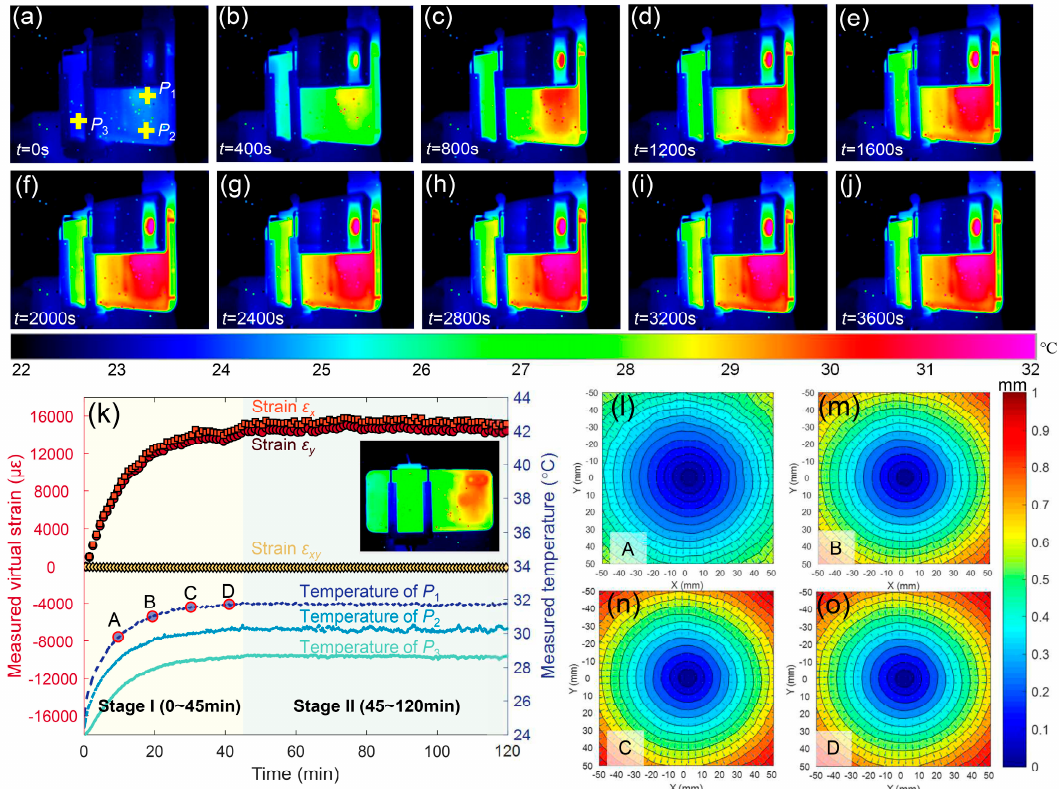
Figure 6. Temperature maps of the smartphone back surface monitored by the thermal camera during the static test: ( a ) t = 0 s, ( b ) t = 400 s, ( c ) t = 800 s, ( d ) t = 1200 s, ( e ) t = 1600 s, ( f ) t = 2000 s, ( g ) t = 2400 s, ( h ) t = 2800 s, ( i ) t = 3200 s and ( j ) t = 3600 s. ( k ) Measured virtual strains (unit: µε ) and temperature variations (unit: °C) of P 1, P 2 and P 3 as a function of the test time, ( l–o ) radial displacement vector superimposed on the radial contours at 10, 20, 30 and 40 min.